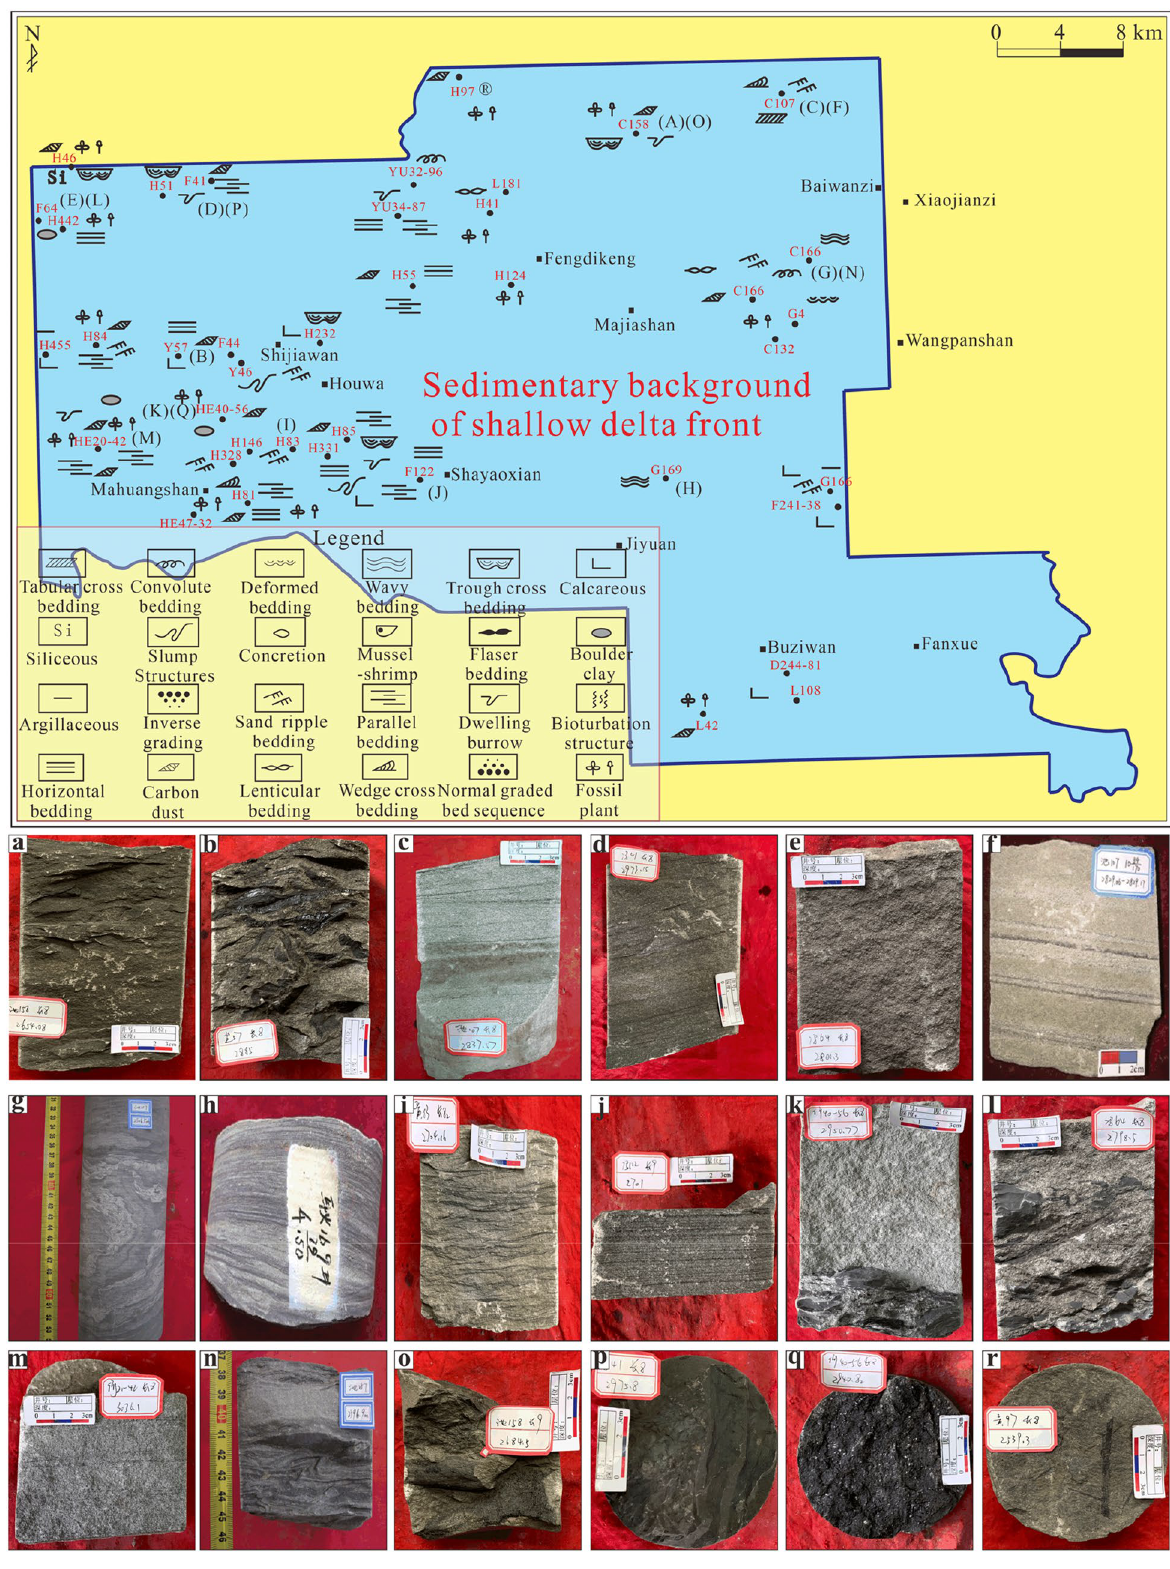
Figure 6. The planar distribution of sedimentary structures in the sub-oil-bearing Chang 8 2